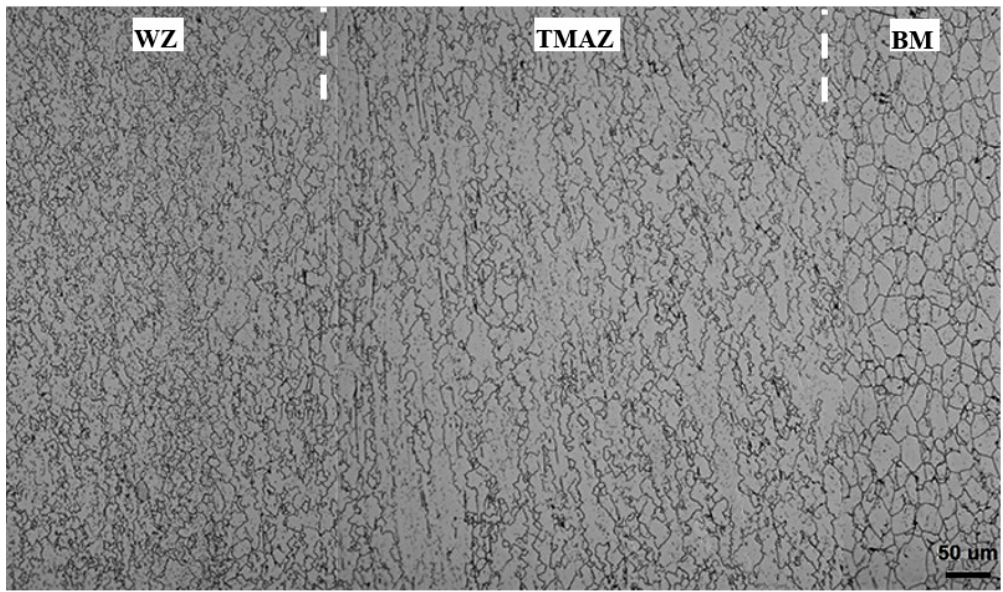
Figure 7. Typical microstructure cataloguing of 304SS joint welded by RFW.